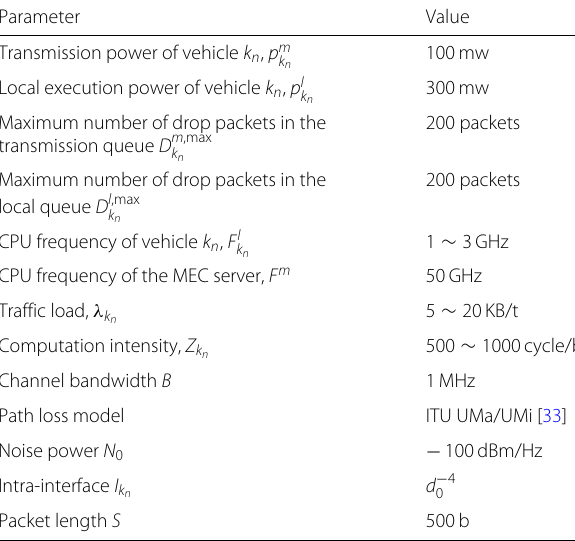
Table 2 Simulation